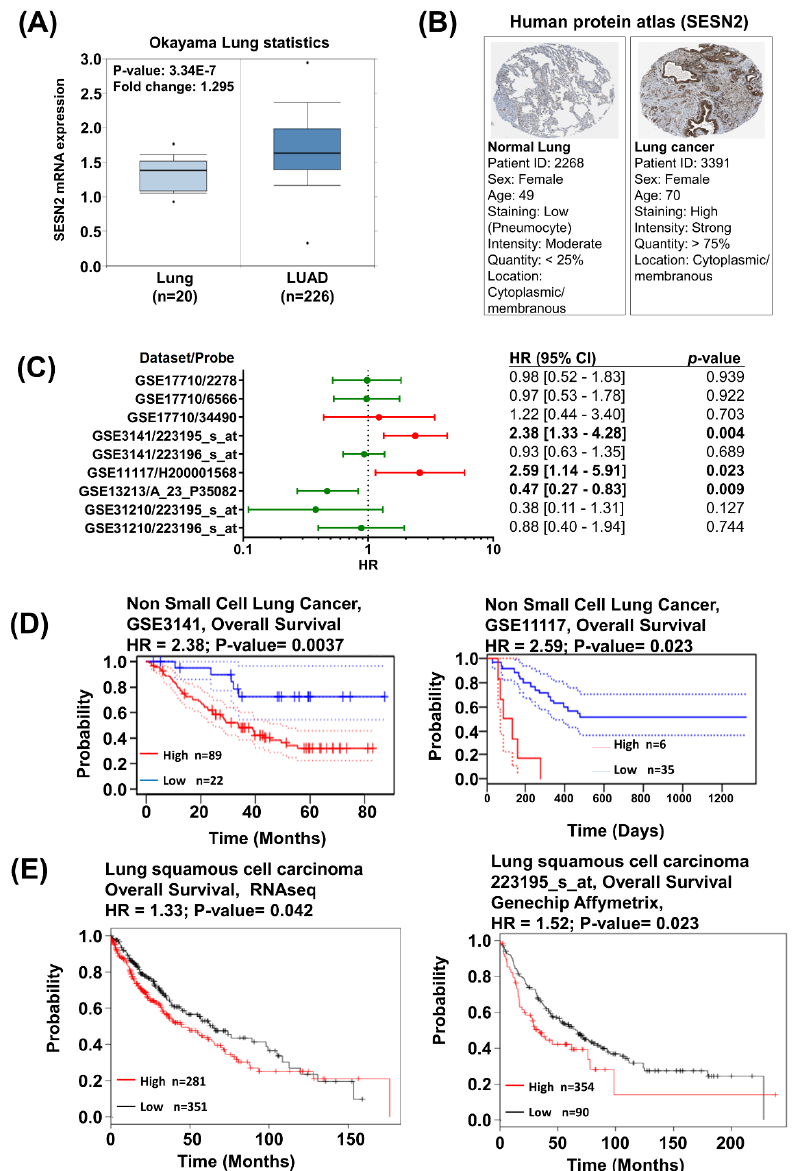
Figure 4. Sestrin2 mRNA expression analysis in lung cancer patients using various bioinformatic databases. ( A ) Oncomine database analysis of Okayama Lung statistics comparing Sestrin2 mRNA expression in normal lung with that in lung cancer. ( B ) Human Protein Atlas analysis for patient tissue staining. The normal lung tissue is stained with a low amount of Sestrin2 antibody (patient ID = 2268) while the lung cancer tissue is stained with a high amount of Sestrin2 antibody (patient ID = 3391) ( C ) Forest plots of GEO datasets evaluating association of sestrin2 expression and overall survival in lung cancer datasets in Prognoscan database. Hazard ratio (HR) with 95% confidential interval (CI) and p-values are labeled in the right column of each forest plot. ( D ) The survival rate graph compares high (red) and low (blue) Sestrin2 expression in non-small cell lung cancer patients. Prognoscan database analysis survival curve plotter using GSE3141–overall survival (hazard ratio = 2.38, p -value = 0.0037) (high n = 89, low n = 22) and GSE11117–overall survival (hazard ratio = 2.59, p -value = 0.023) (high n = 6, low n = 35) datasets. ( E ) The survival rate graph compares high (red) and low (black) Sestrin2 expression in lung squamous cell carcinoma patients. The 223195_s_at dataset was analyzed with RNAseq and A ff ymetrix Genechip using KM